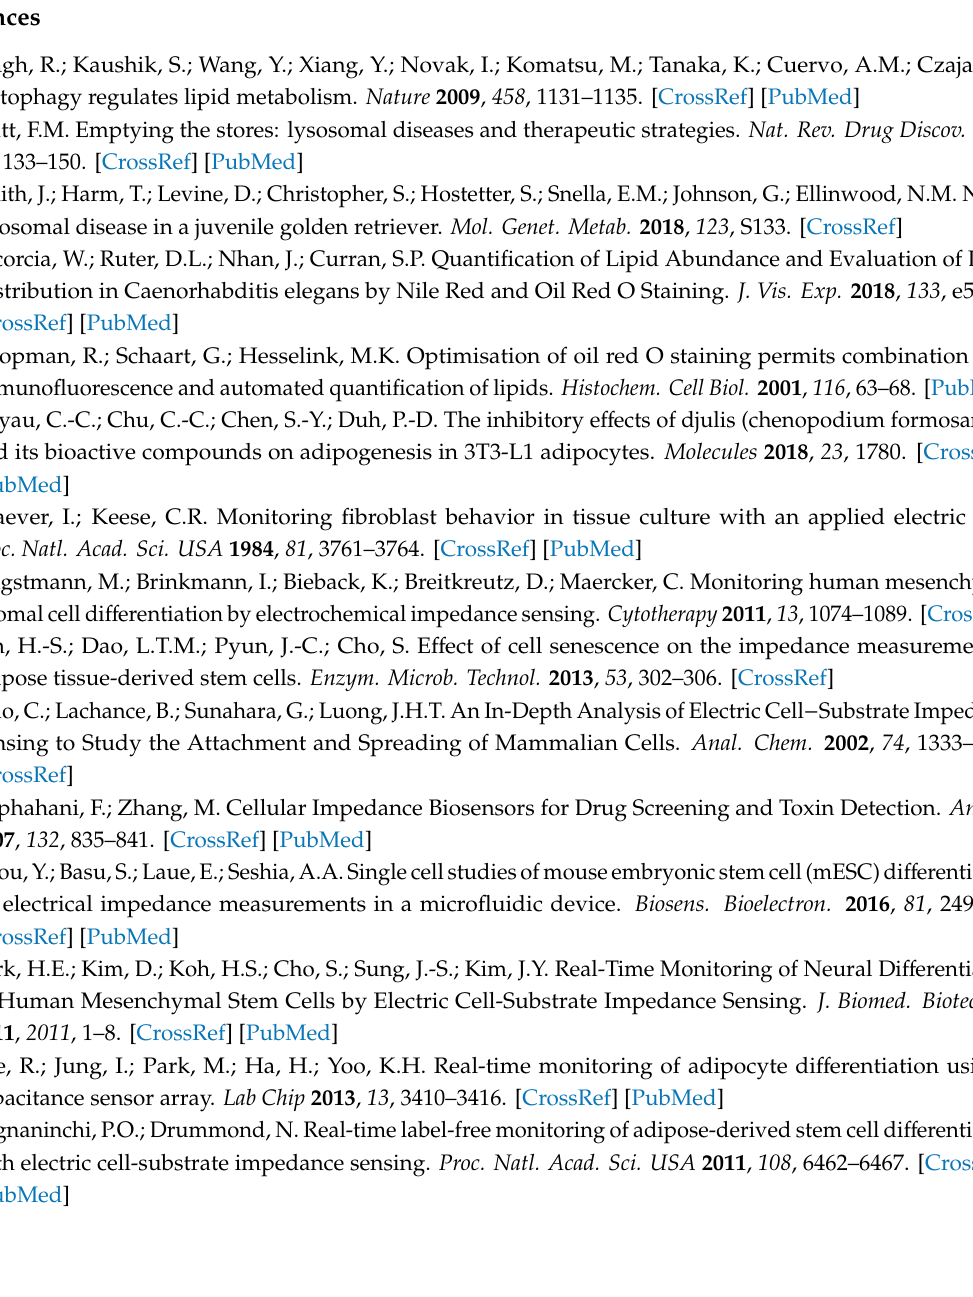
Figure S1: ( a ) Phase-contrast and ( b ) Oil red O stained images of di ff erentiated 3T3-L1 cells. Scale bar: 100 µ